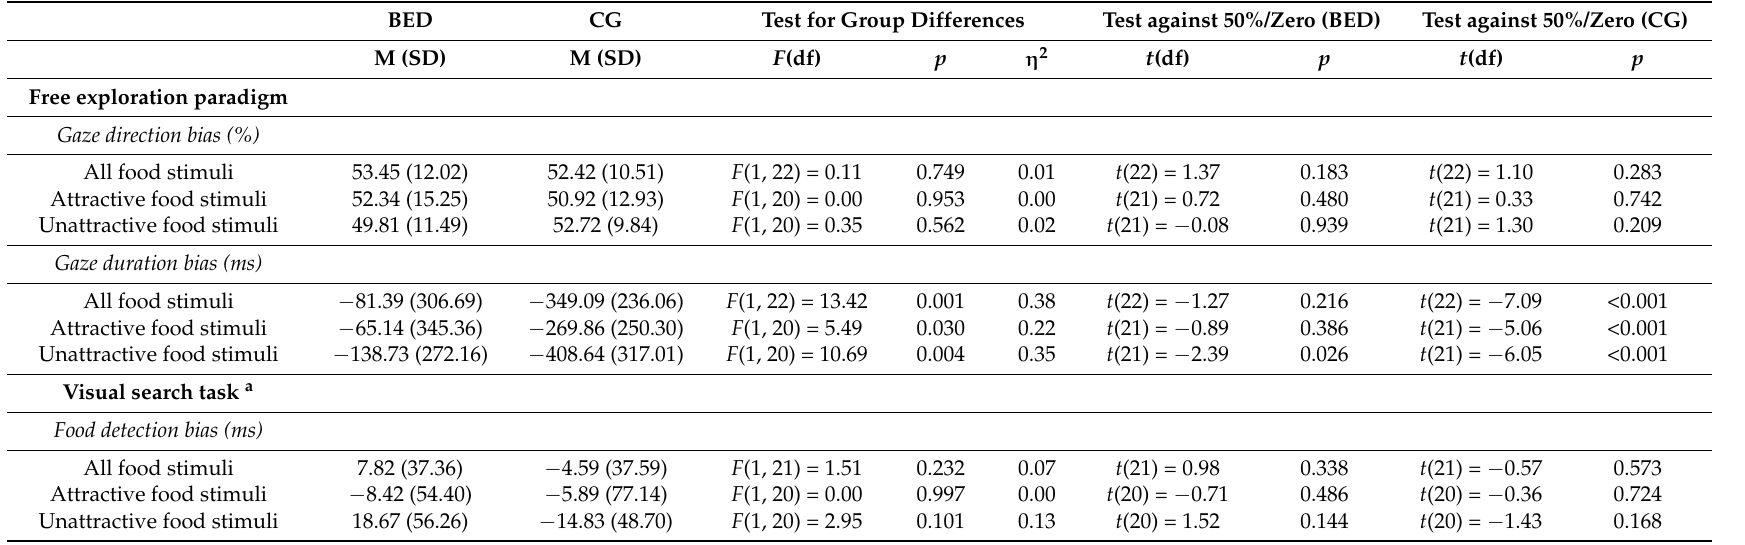
Table 2. Attentional bias scores as a function of group